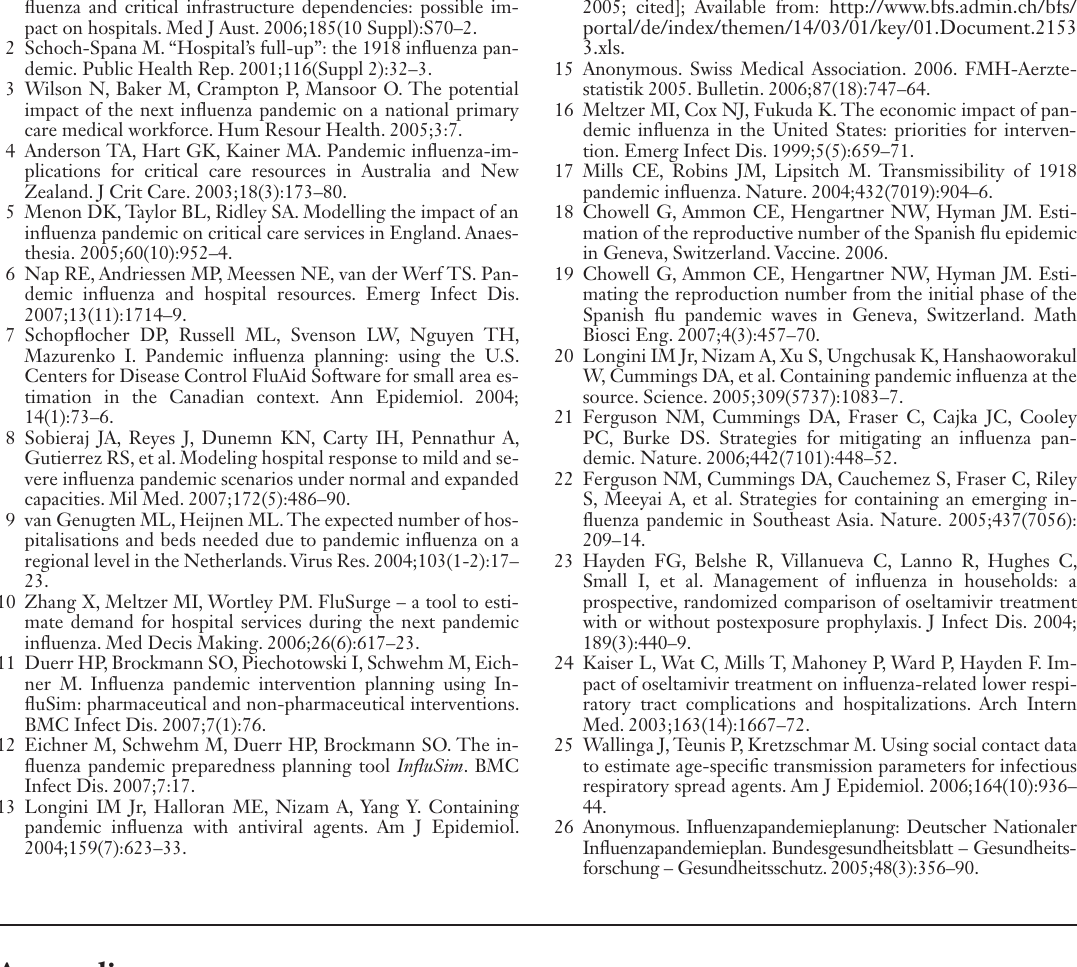
Age distribution of the Swiss population (per 100000), contact matrix and risk of hospitalization and death from influenza by age class and risk group. Children